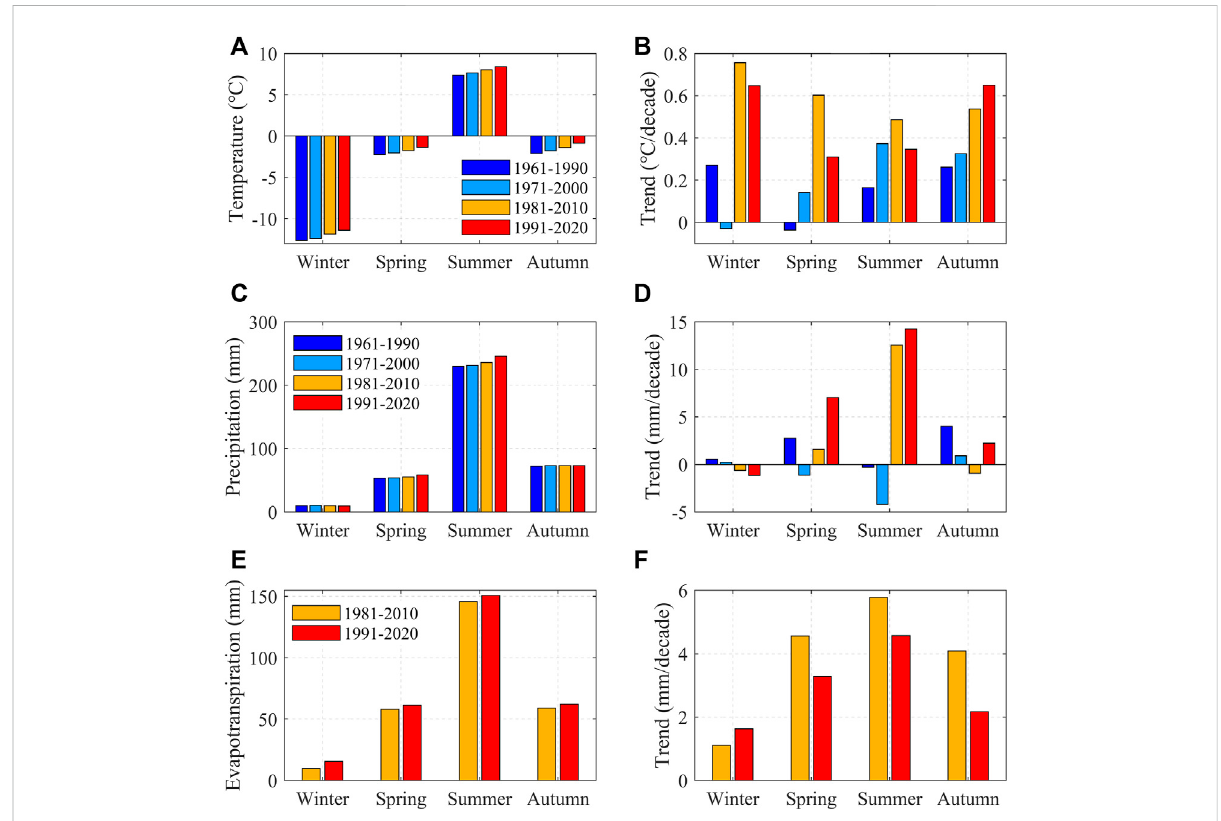
FIGURE 3 SeasonalchangesofclimatevariablesintheTibetanPlateau.Fromlefttoright:resultsforaveragedvalueandtrend.Fromtoptobottom:results for temperature (A – B) , precipitation (C – D) , and evapotranspiration (E – F)